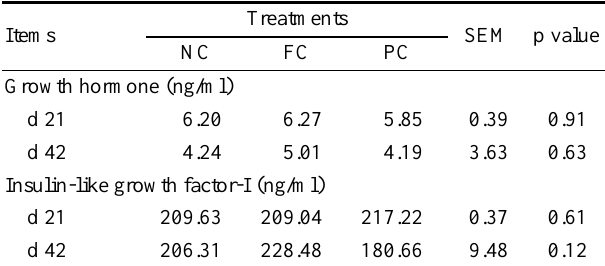
Table 6. Effects of dietary Forsythia suspensa extract (FSE) supplement on serum growth hormone and IGF- I concentrations (ng/ml) in broilers